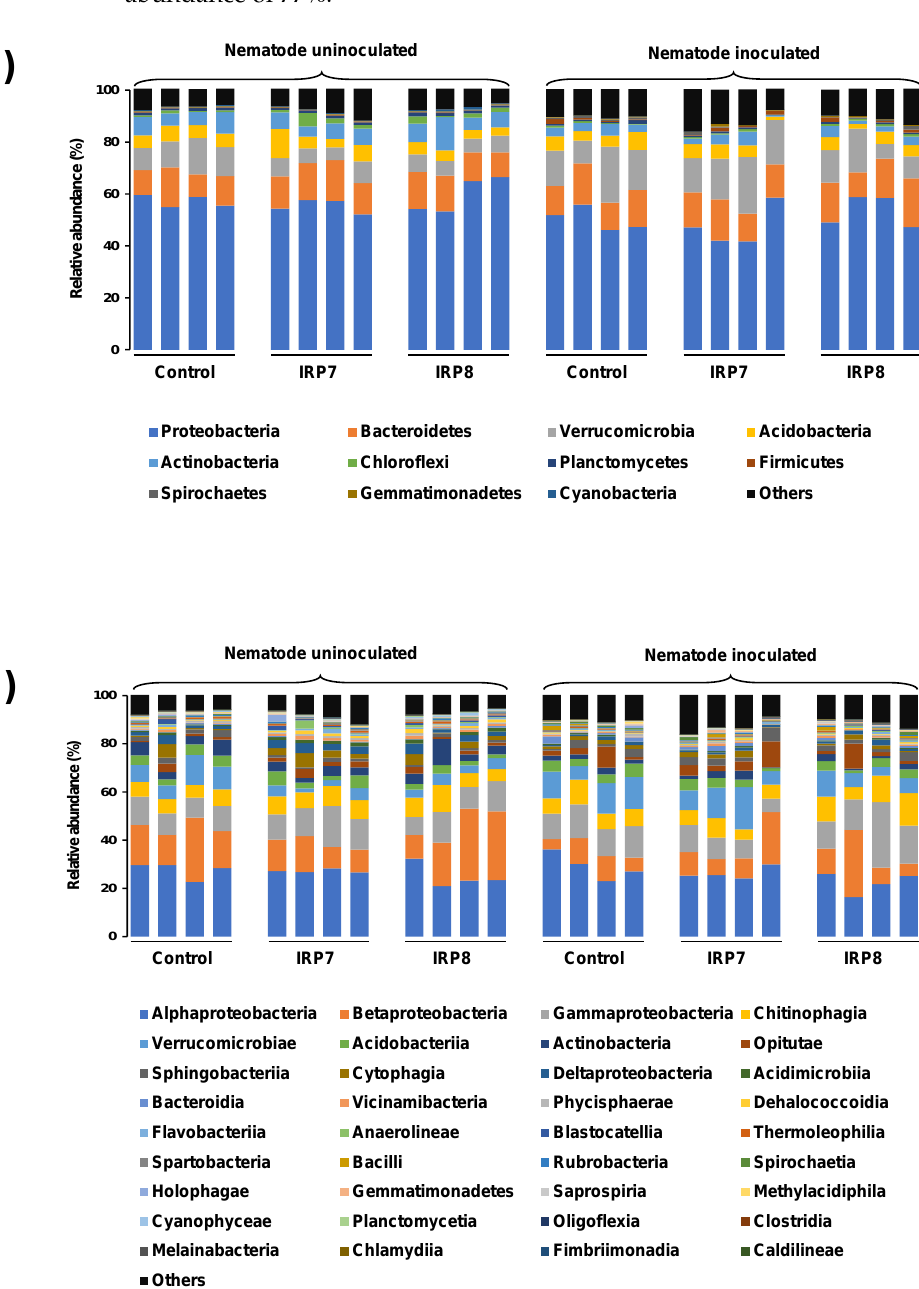
Figure 4. Stacked bar graph for the relative abundance of bacterial 16S rRNA at ( A ) the phylum and ( B ) class levels using rhizosphere samples of the nematode ( Bursaphelenchus xylophilus )-inoculated and -uninoculated pine seedlings treated with Pseudomonas koreensis IRP7 or Lysobacter enzymogenes